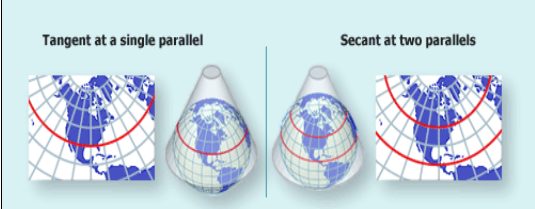
Figure 3: Conic projections with tangent or secant cones. (Source USGS, National Atlas, as Figure 2, public domain)